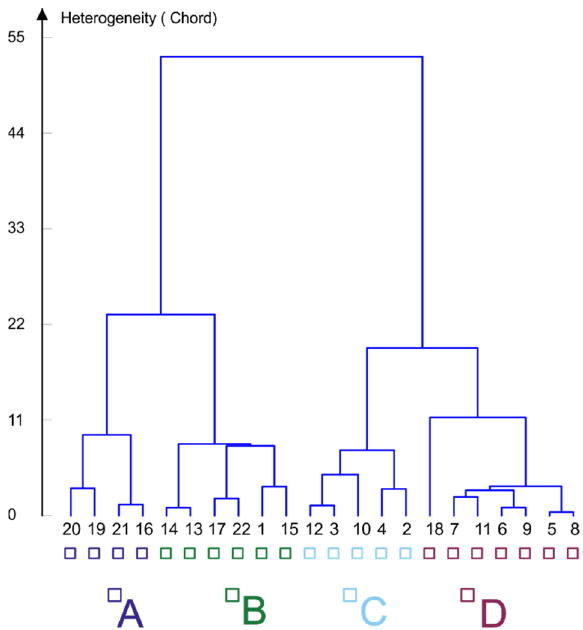
Figure 3. Hierarchical cluster analyses (Ward’s method) of the Chironomidae assemblages. Four assemblage types (obtained through K-means clustering) are in capital letters A, B, C, D coloured as indicated. The numbers represent study sites codes (see Figure 1).